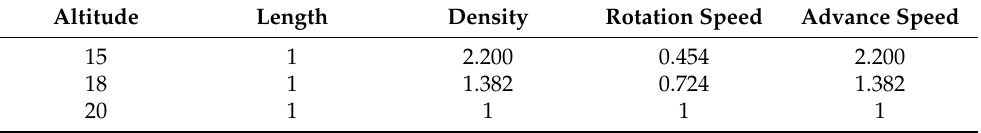
Table 3. Scaling ratio at different altitudes.